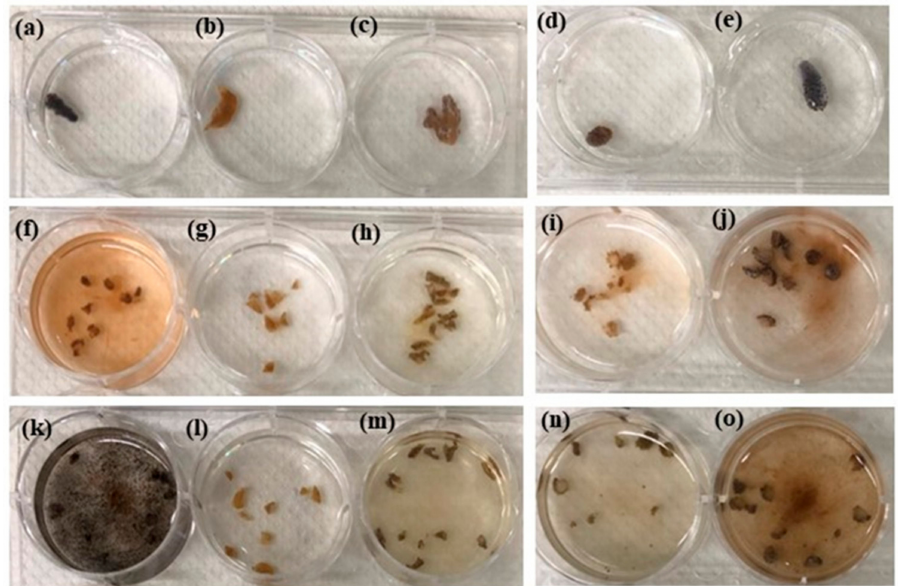
Figure 7. The amount of black pigment released by different kinds of octocorals. ( a – e ) Tentacles about 1 cm long from five different species of octocorals were collected in 6-well plates; ( f – j ) these octocorals were cut into small pieces and incubated in FSW (36‰); ( k – o ) after 20 h, the amounts of black pigment were observed.